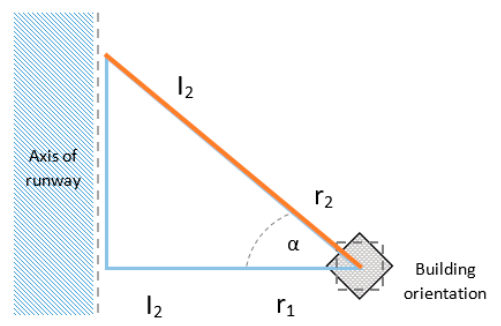
Figure 15. Building orientation angle toward runway.